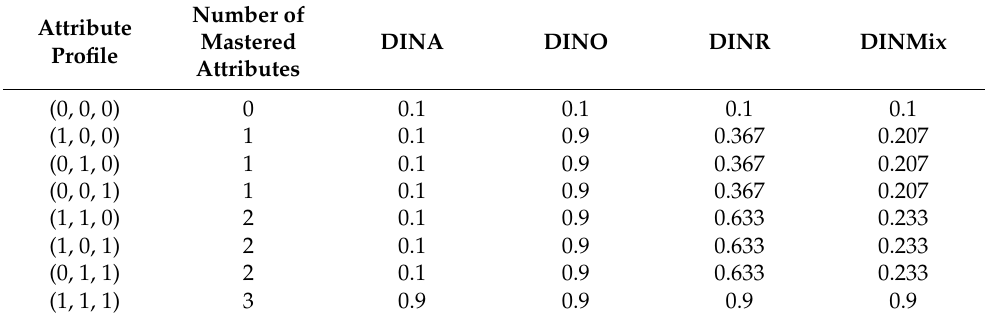
Table 1. The Correct Response Probabilities of Four Deterministic Input, Noisy Models for an